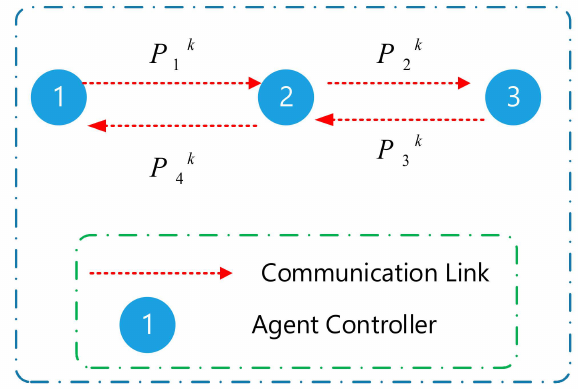
Figure 2. Exchange information among agents.